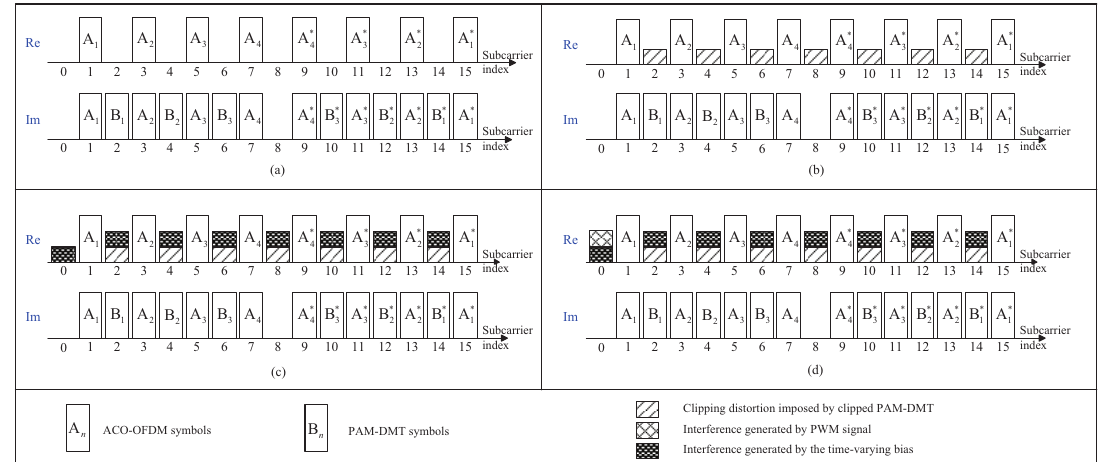
Figure 1. Frequency-domain demonstration including both the real component and the imaginary component of the proposed DCHO-OFDM signal, with N = 16 subcarriers. ( a ) presents the symbol allocation for ACO-OFDM and for PAM-DMT branch, respectively; ( b ) demonstrates the hybrid unclipped ACO-OFDM and the down/upper-clipped PAM-DMT signals; ( c ) indicates the combined signal after performing time-varying biasing scheme; ( d ) depicts the hybrid signal further incorporating the PWM